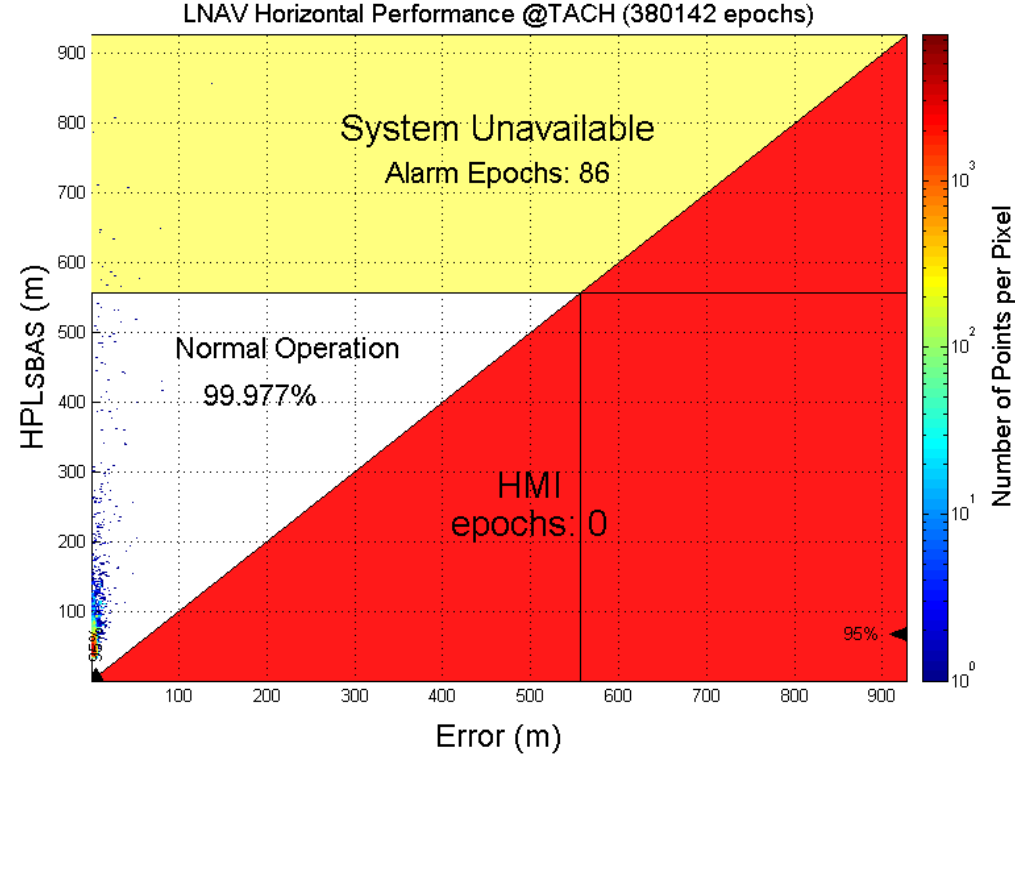
Figure 24. The LNAV (NPA) performance of the developed WADGPS with 3 RSs in Taipei